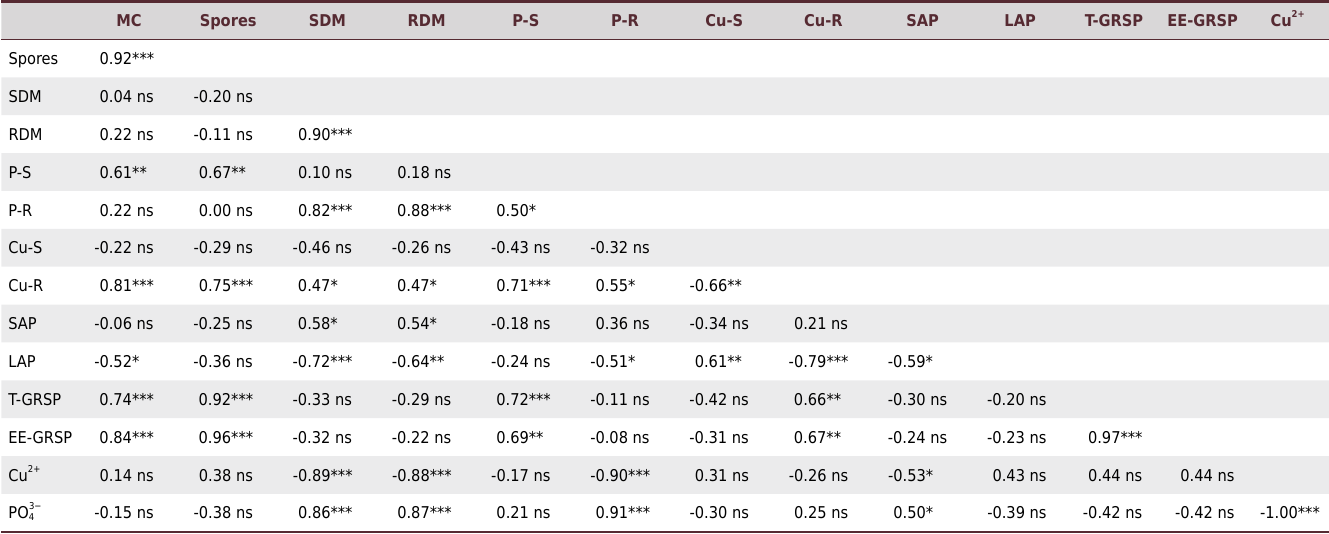
Table 2. Correlation matrix of some-selected experimental variables